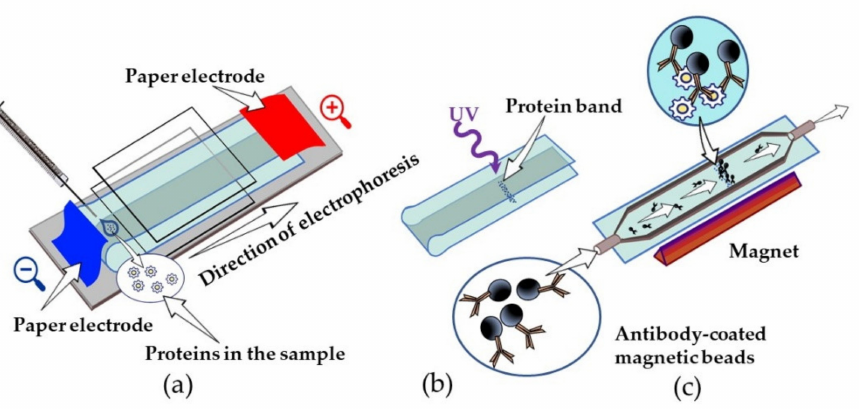
Figure 8. Rapid ultrasensitive gel-free immunoblotting with magnetic labels. ( a ) Separation of ana- lyzed proteins on nitrocellulose under non-denaturing conditions; ( b ) photochemical immobilization of analyte; ( c ) antibody-coated magnetic bead visualization.